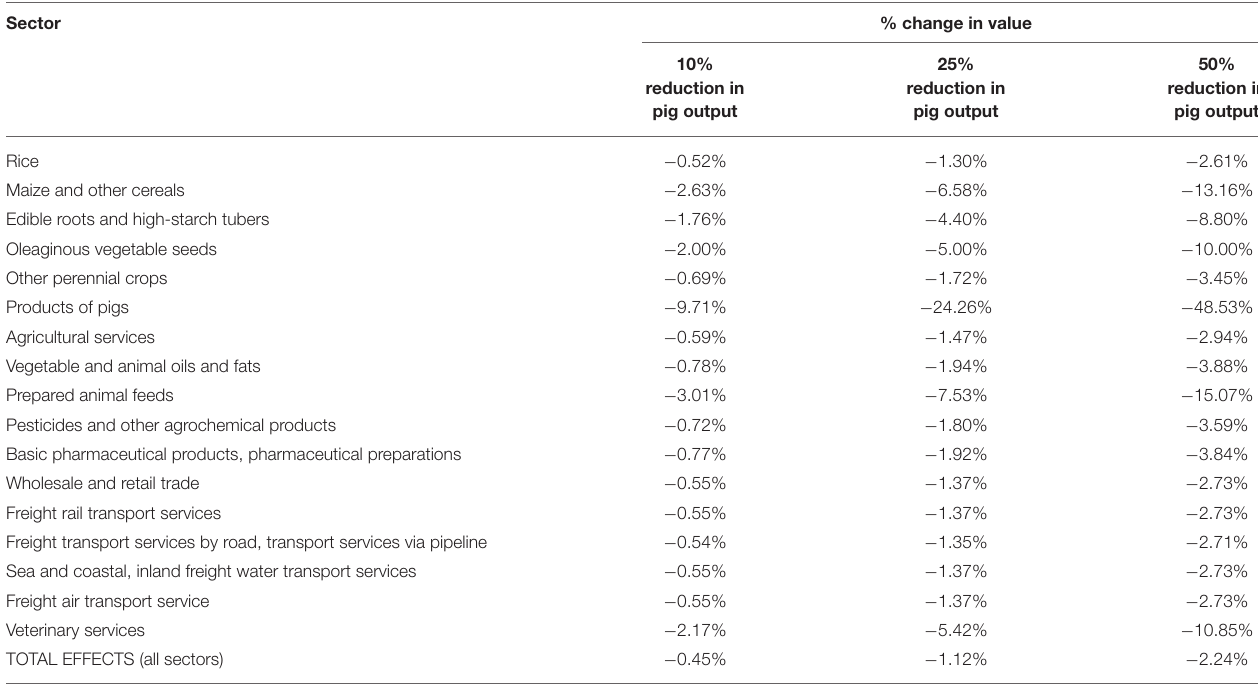
TABLE 4 | Sectors most negatively affected * by a reduction in the value of pig output caused by ASF under different scenarios. Sector